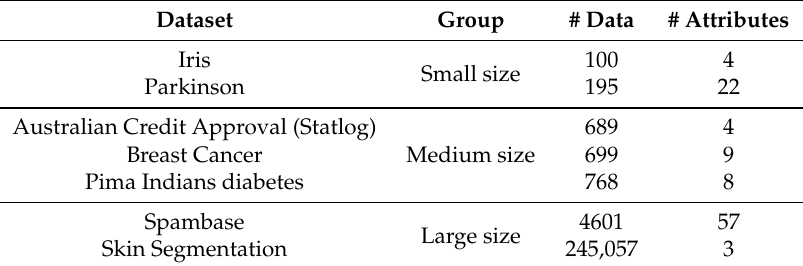
Table 6. Data specification for benchmarking for 2-Classes